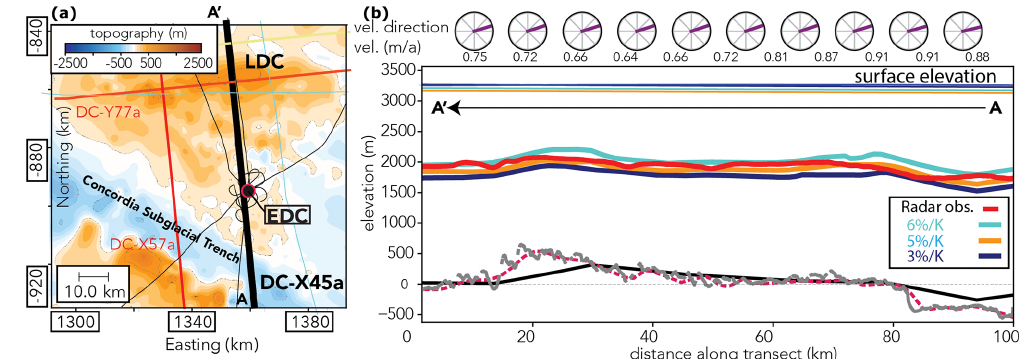
Figure 5. Transect DC-X45a with the 96ka isochrone. Panel (a) illustrates the bedrock elevation and radar transects analysed in this study crossing Dome C. In (b) the computed isochrone elevations for simulations with 3%, 5% and 6% precipitation change per Kelvin surface temperature change are plotted against the observed isochrone (red line). The modelled surface elevation is plotted in the corresponding colour of the modelled isochrones, and the observed surface elevation (Fretwell et al., 2013) is depicted in dark blue. Bedrock elevation in the model is plotted in black and bedrock elevation derived from the radar transect in grey. The gridded 1km BedMachine bedrock elevation (Morlighem et al., 2020) is plotted for comparison as well (smooth dashed red line). The circles on the top of (b) denote the relative flow direction and speed with respect to the radar